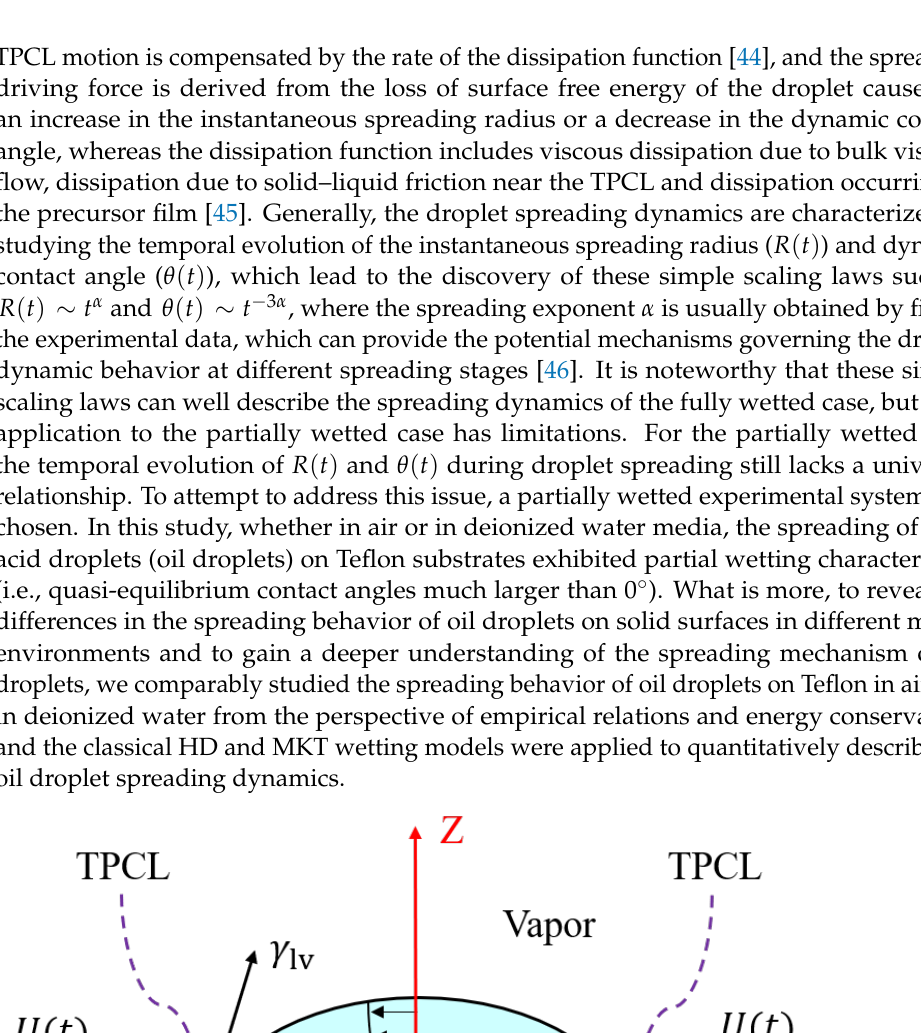
on the Teflon in water [43].